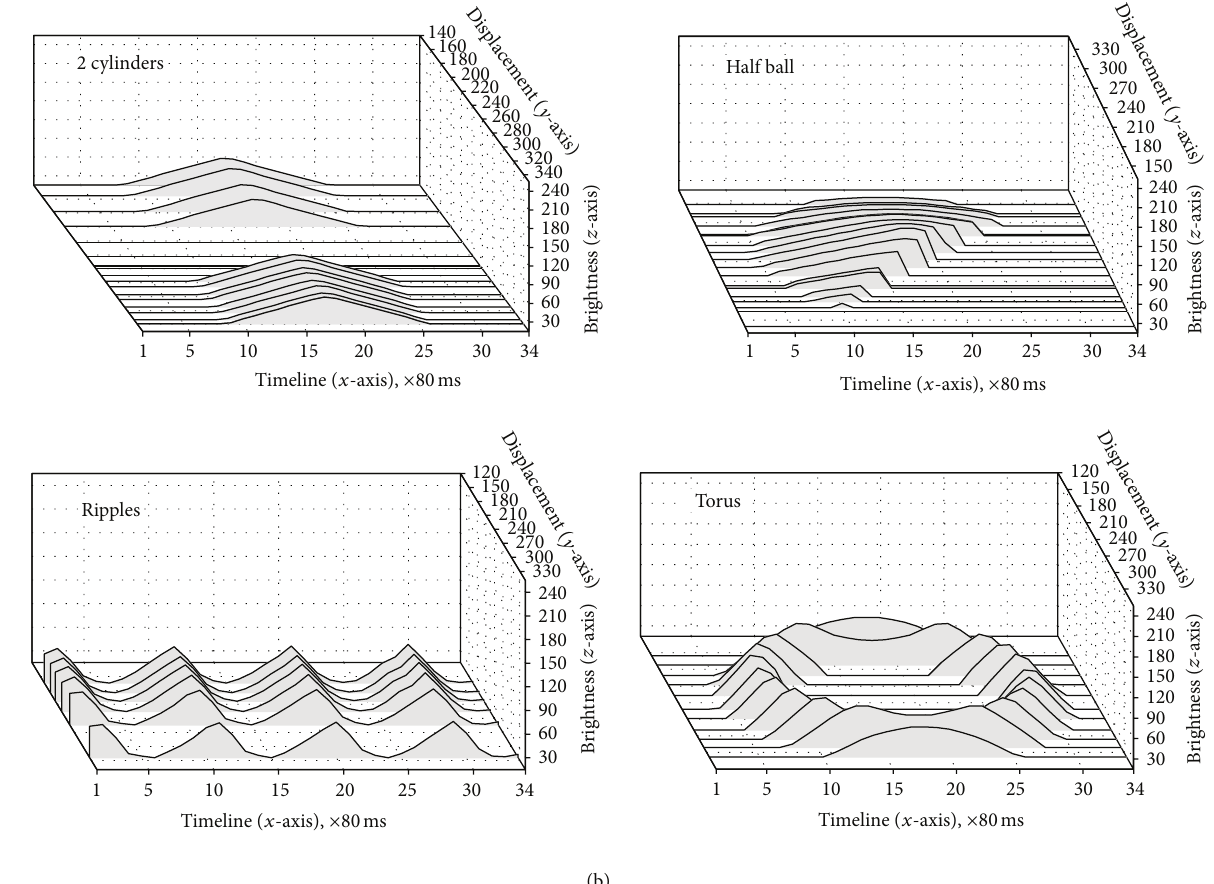
Figure 5: (a) Typical tracks recorded during haptic exploration and identification of virtual volumetric shapes in the parallel scanning mode. The repeated inspection and exploration in more detail were required with respect to shapes having smooth rounded surfaces. (b) 3D reconstruction of the virtual shapes explored in the parallel scanning